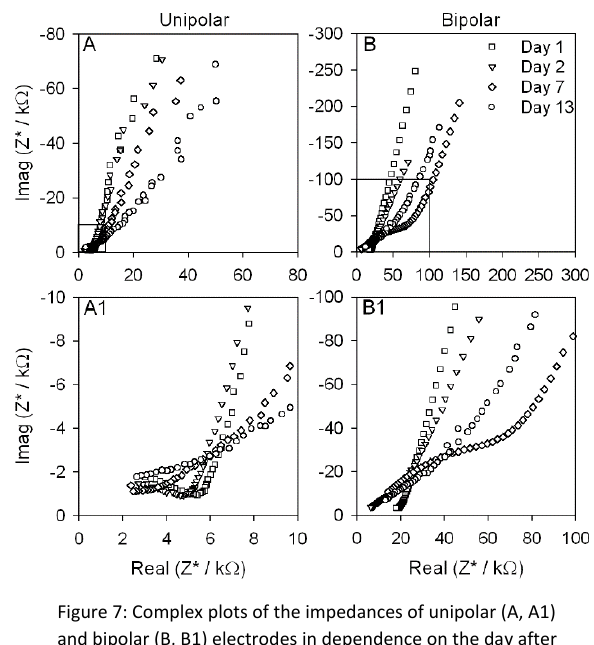
Figure 7: Complex plots of the impedances of unipolar (A, A1) and bipolar (B, B1) electrodes in dependence on the day after implantation. Each spectrum was measured in a frequency range of 100 Hz to 10 MHz. For clarity, not all measuring points were plotted. (A1) and (B1) are zooms of (A) and